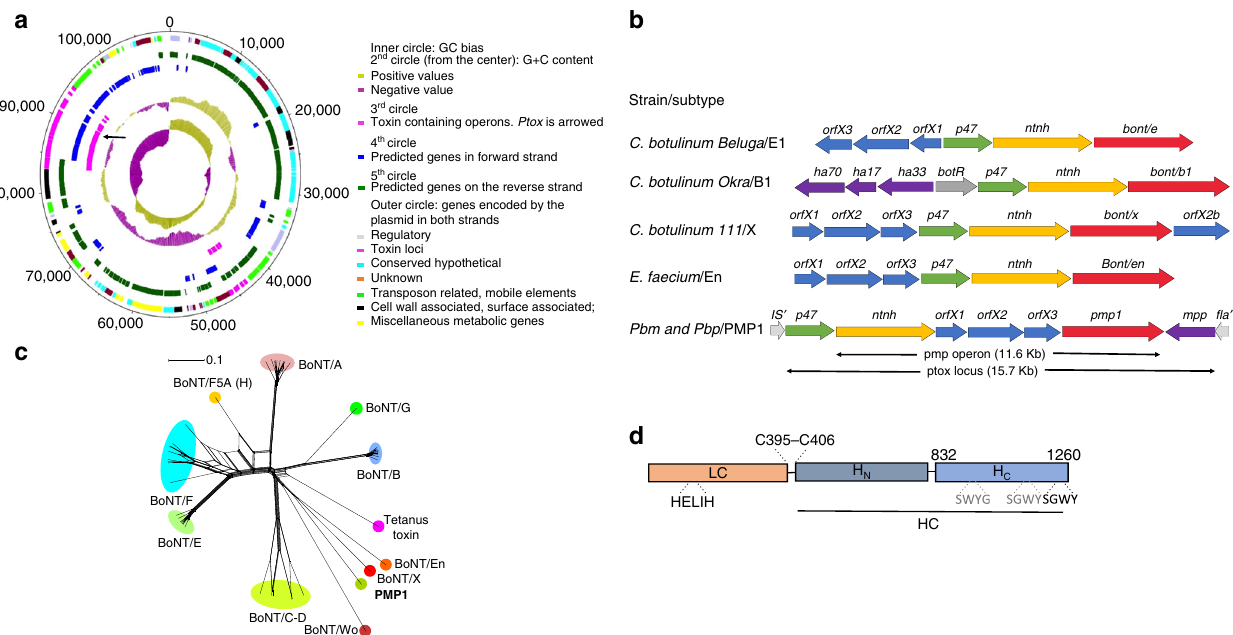
Fig. 1 Analysis of ptox locus and paraclostridial mosquitocidal protein 1 (PMP1) sequences. a Map of the 109 kb megaplasmid in Paraclostridium bifermentans subsp. malaysia ( Pbm ) and Pb paraiba ( Pbp ). b Con fi guration of clostridial neurotoxin loci in different Clostridium and non- Clostridium strains and in Pbm . c Phylogenetic split network covering all botulinum neurotoxin (BoNT) serotypes, subtypes, mosaic toxins, and tetanus neurotoxin (TeNT). PMP1 is in bold. The scale bar represents the split support for the edges 47 . d Schematic drawing of the three domains of PMP1 showing the conserved elements found in clostridial neurotoxins: HELXH motif in the light chain (LC), the cysteines that form disul fi de bond between LC and heavy chain (HC) and the tandem SxWY motif in the